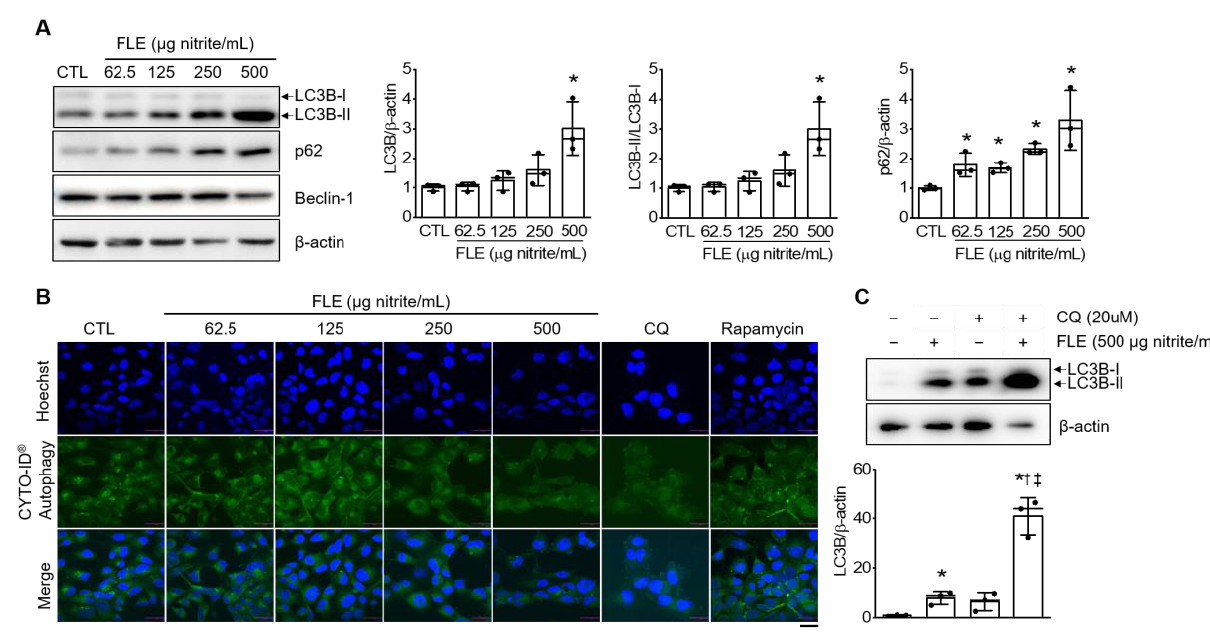
Figure 5. FLE induces autophagosome formation and thus regulates autophagy in MH7A cells. ( A ) Western blotting of LC3B, p62, and beclin-1 expression in MH7A cell lysates after 72 h treatment with FLE ( n = 3). ( B ) Autophagy flux in MH7A cells after FLE treatment for 72 h. Cells were stained with CYTO-ID (green) and Hoechst (blue). Scale bar represents 30 μm. ( C ) LC3B expression in MH7A cell lysates after 72 h treatment with or without FLE and CQ. Data are shown as means ± SD. * p < 0 .05, compared to CTL. † p < 0.05, compared to FLE. ‡ p < 0.05, compared to CQ. The plus (+) sign represents treated CQ or/and FLE. The minus ( −) sign represents untreated samples.